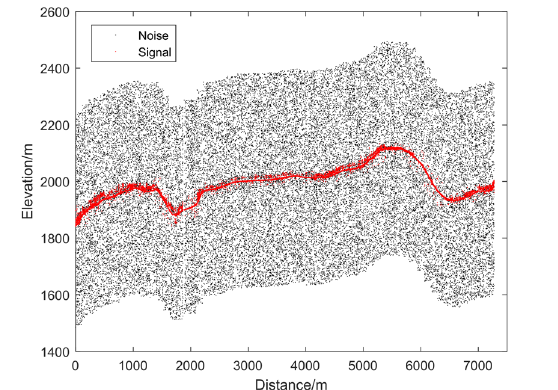
Figure 10 . Result of hierarchical adaptive filter.